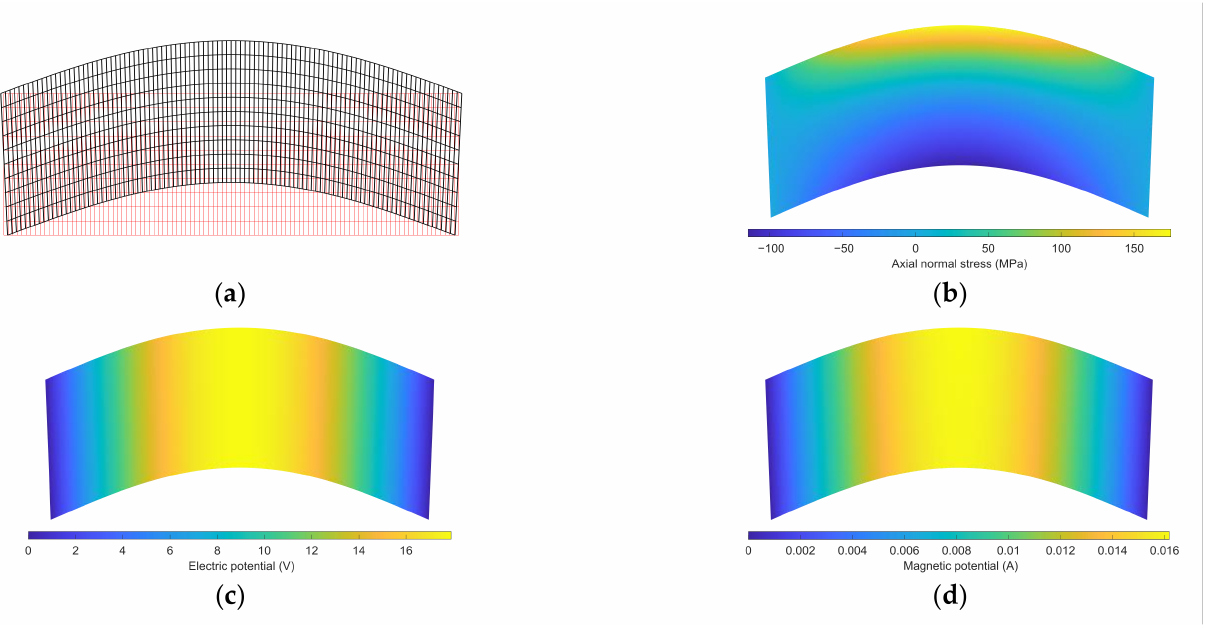
Figure 3. Distribution of ( a ) deformation, ( b ) axial normal stress, ( c ) electric potential, and ( d ) mag- netic potential (porosity coefficient e 0 =